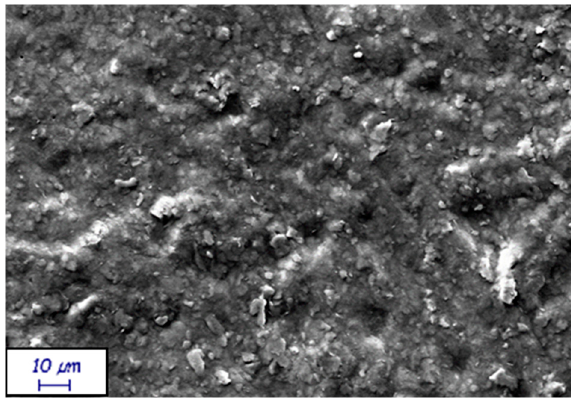
Figure 4. Surface morphology of KB H39K 40 (magnification: 2000×). The sample results are rough due to the high filler concentration.